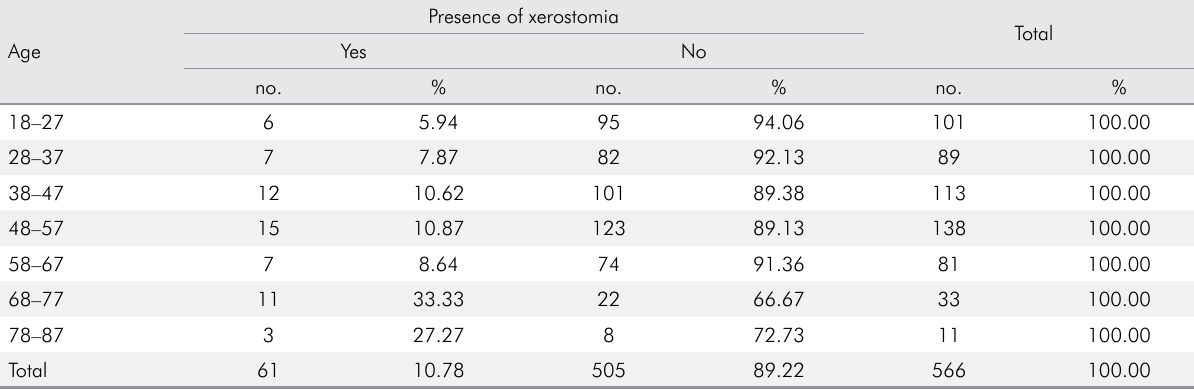
Table 1. Prevalence of xerostomia by age group.